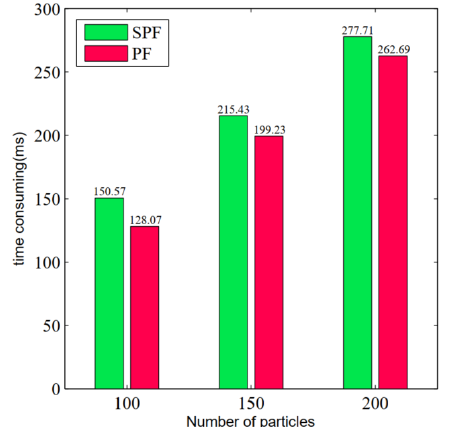
Figure 9. Time-consumption comparison with different numbers of